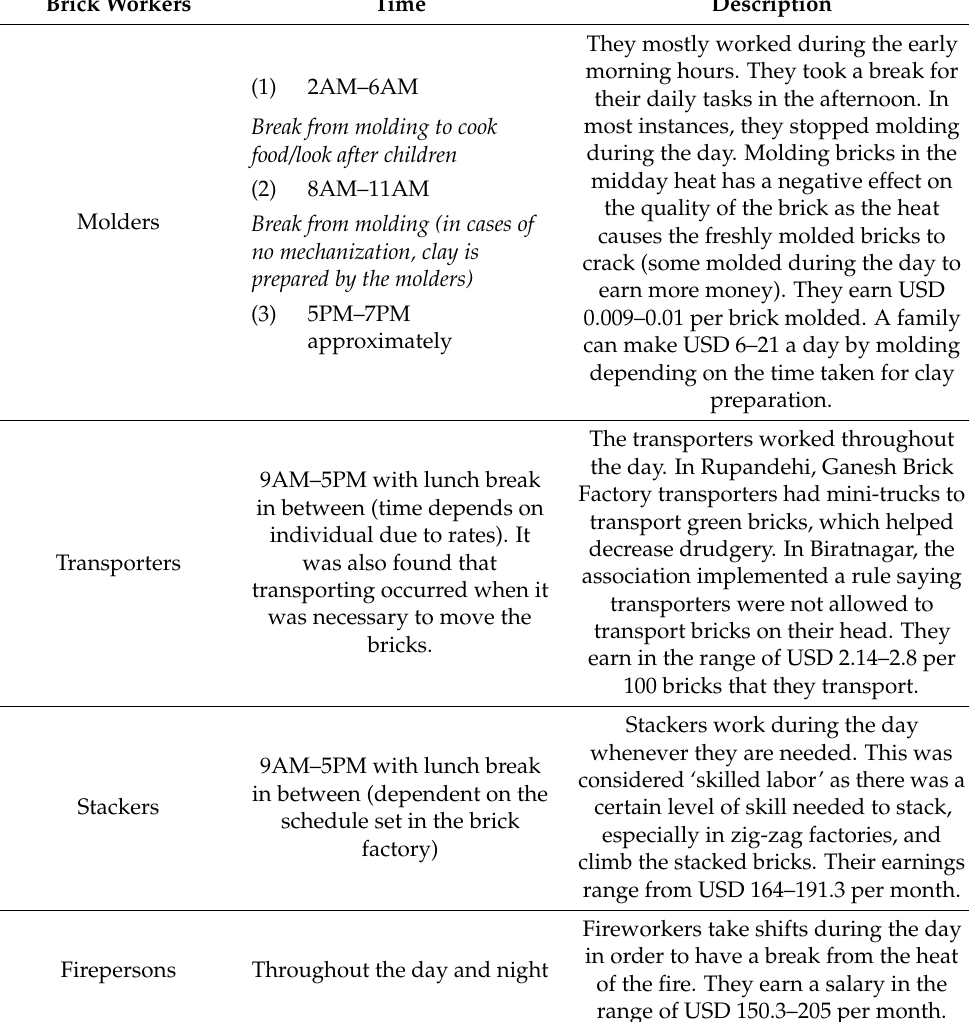
Table 3. Working hours and earnings of different categories of workers in the brick